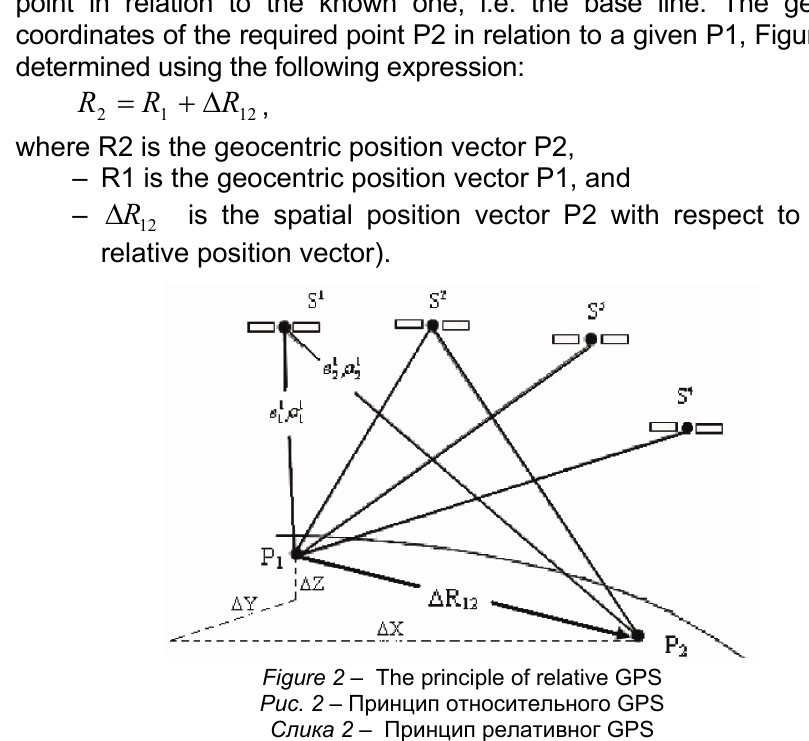
Figure 2 – The principle of relative GPS Рис . 2 – Принцип относительного GPS Слика 2 – Принцип релативног